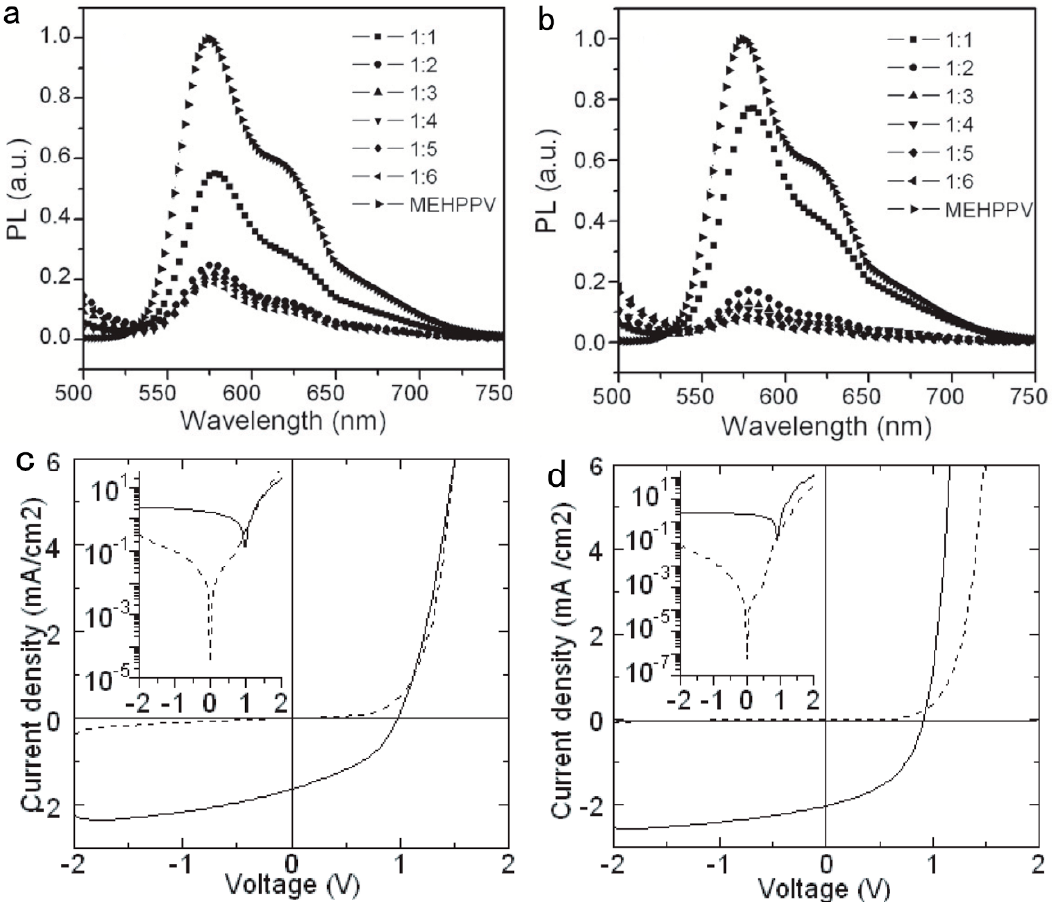
Figure 2. Photoluminescence intensity of MEH-PPV: CdSe nanocrystal (NC) blends as a function of the weight fraction of CdSe NCs under excitation at 500 nm: ( a ) CdSe NCs prepared by Se powder, ( b ) CdSe NCs prepared by trioctylphosphine/Se injection. Current density–voltage ( J – V ) characteristics of a MEH-PPV: CdSe NC device with the weight ratio of 1:8 ( c ) without and ( d ) with annealing at 180 ° C for 20 min. The dotted line was measured in the dark and the solid line under 1.5 AM solar illumination. The insets are the J – V curves with current density (J) expressed in logarithmic coordinates. Reproduced with permission from [22], Copyright © 2006, IOP Publishing.